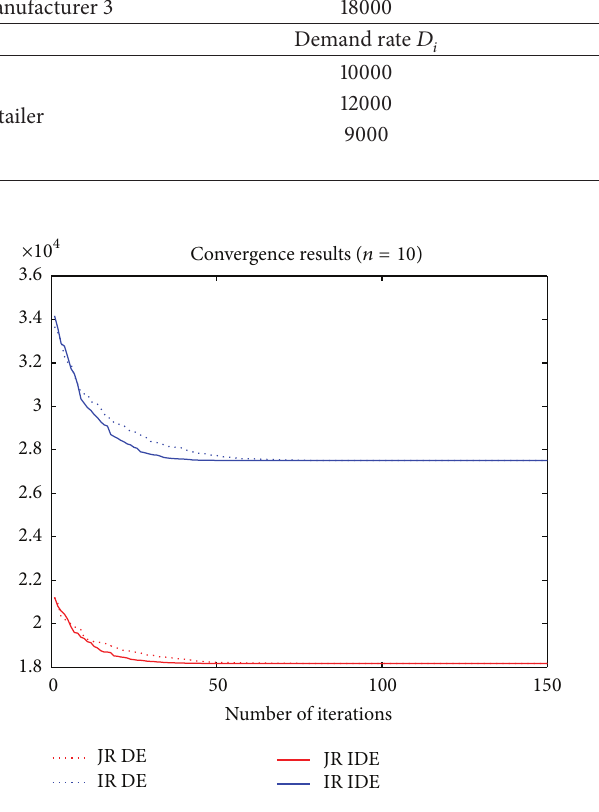
Figure 6: The average convergence curves ( 𝑛 = 10 ). Figure 7: The average convergence curves ( 𝑛 = 30 ).